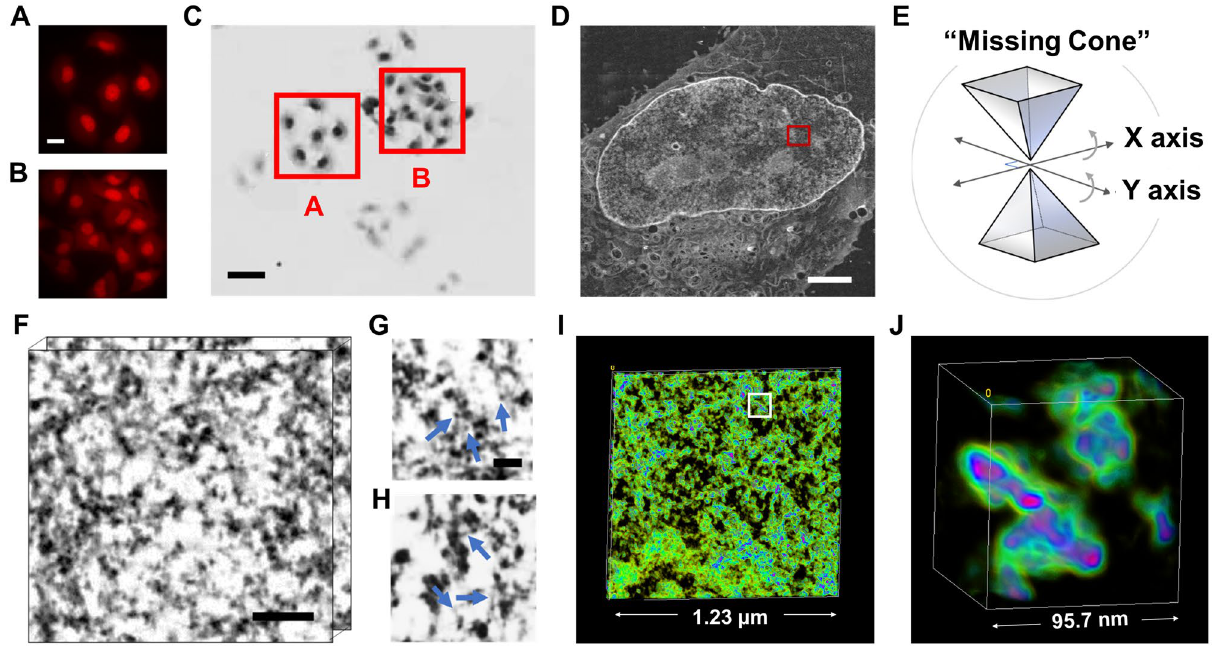
Figure 1. ChromSTEM tomography reconstruction of chromatin in an A549 cell. ( A , B ) The DRAQ5 photo- oxidation process takes 7 min for each region of interest. Scale bar: 10 µm. ( C ) The DRAQ5-labeled regions were more intensely stained than the nearby regions (red squares; the letter corresponds to the regions in the left panels). Scale bar: 20 µm. ( D ) STEM image of a 100 nm thick section of an A549 cell in HAADF mode. Scale bar: 2 µm. ( E ) Schematics for dual-tilt tomography. The sample was tilted from − 60° to 60° with 2° increments on two perpendicular axes. ( F ) 3D tomography of the A549 chromatin. Scale bar: 120 nm. ( G , H ) The fine structure of the chromatin fiber: nucleosomes (blue arrows in G ), linker DNA (blue arrows in H ) Scale bar: 30 nm. ( I , J ) 3D rendering of the chromatin organization, the pseudo-color was based on the intensity of